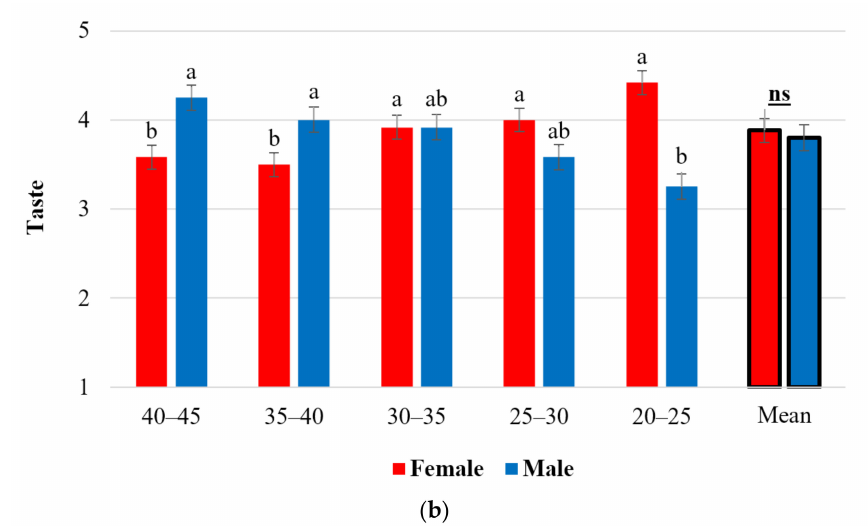
Figure 1. Results obtained for tomatoes taste on a notes scale of 1–5 (1 = weak; 5 = very good): ( a ) Female and male score, depending on genotype; ( b ) Female and male score, depending on the age groups. The notes are expressed as mean ± SD. Any means in the columns followed by the same letter are not significantly different (Duncan test, α < 0.05). On the latest columns, the average values by types of tasters (women-men) were compared using t -test (Student), α <